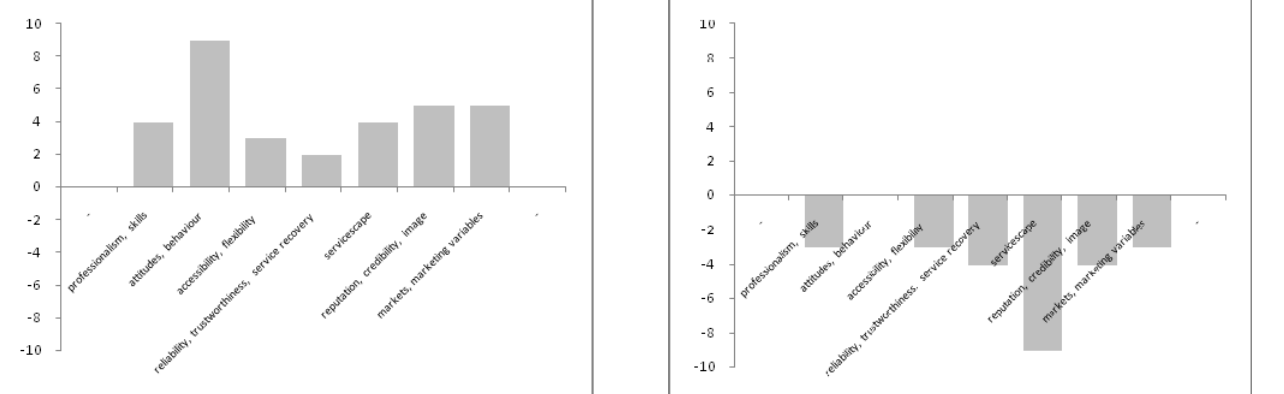
Figure 5: The underlying drivers of consumption in Factor 2